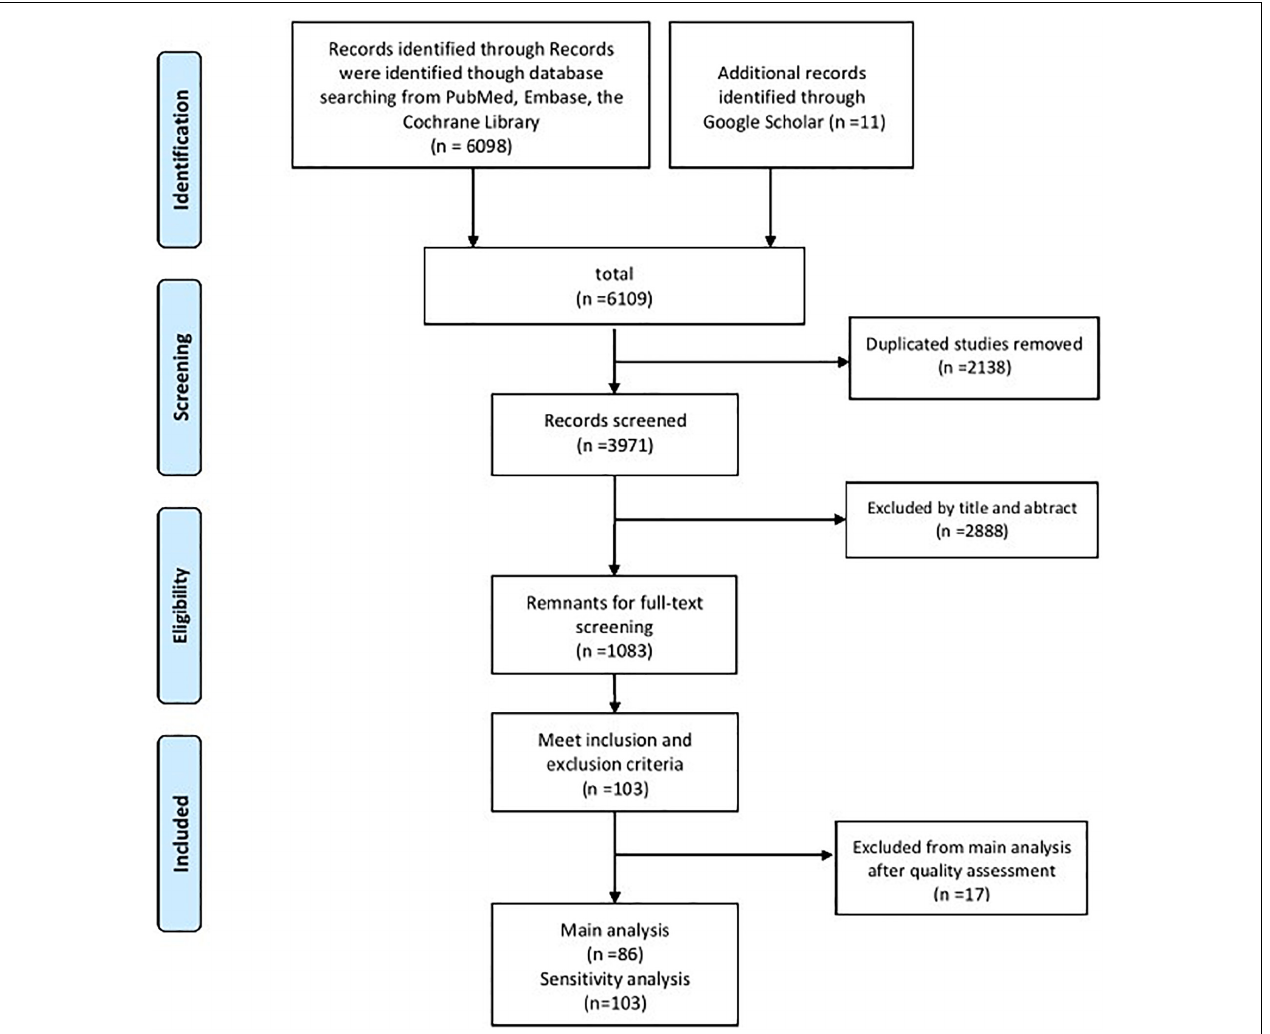
FIGURE 1 | PRISMA flow chart of the studies included in the main analysis and the sensitivity analysis.